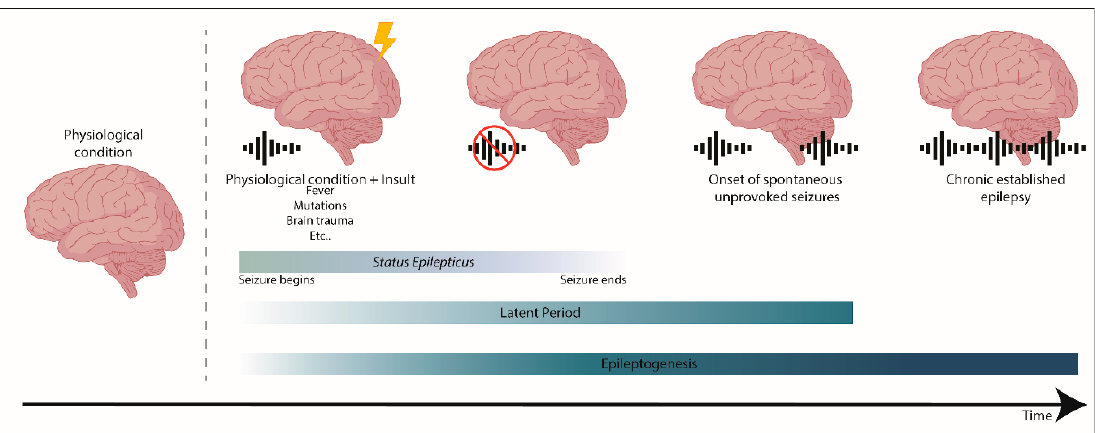
Figure 1. The process of epileptogenesis. Epileptogenesis encompasses three phases: (1) The moment a precipitating injury or event occurs, (2) the latent period, which comprises the time between an epileptogenic insult on a physiological brain, and the generation of a modified epileptic brain with spontaneous seizures, and (3) the mechanisms that occur during established chronic epilepsy. Status epilepticus (SE) is a prolonged seizure or a period of repetitive seizures without returning to the physiological state.